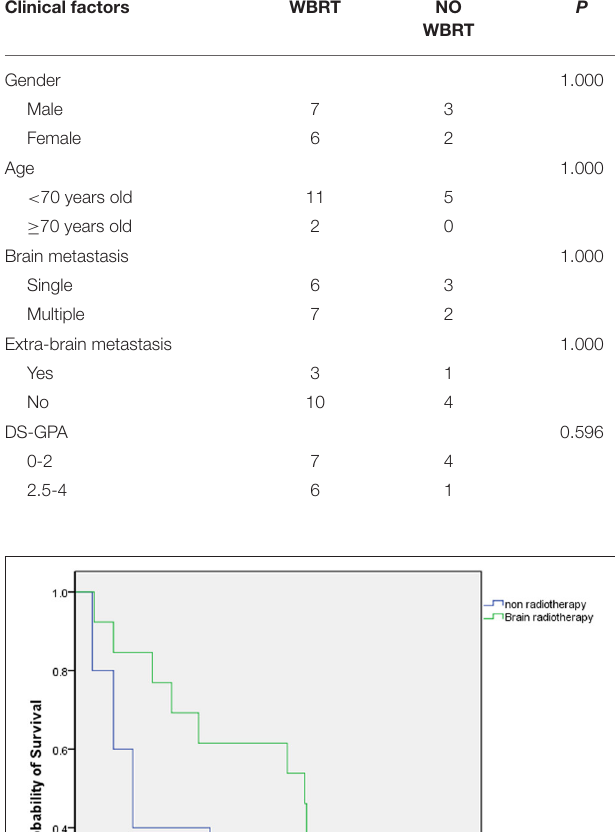
TABLE 4 | Comparison of clinical factors between patients who received whole-brain radioteraphy (WBRT) and those who did not.